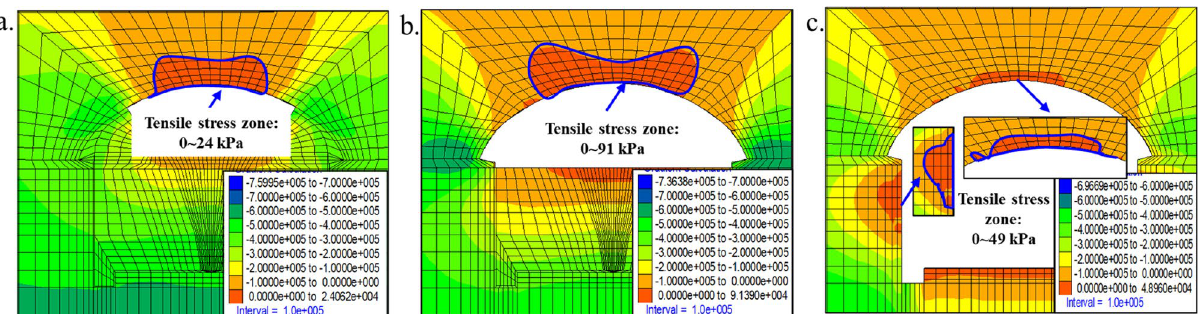
Figure 13. Small principal stress diagram. ( a ) Excavation of the upper steps in the middle of the arch, ( b ) excavation of the arch, and ( c ) all